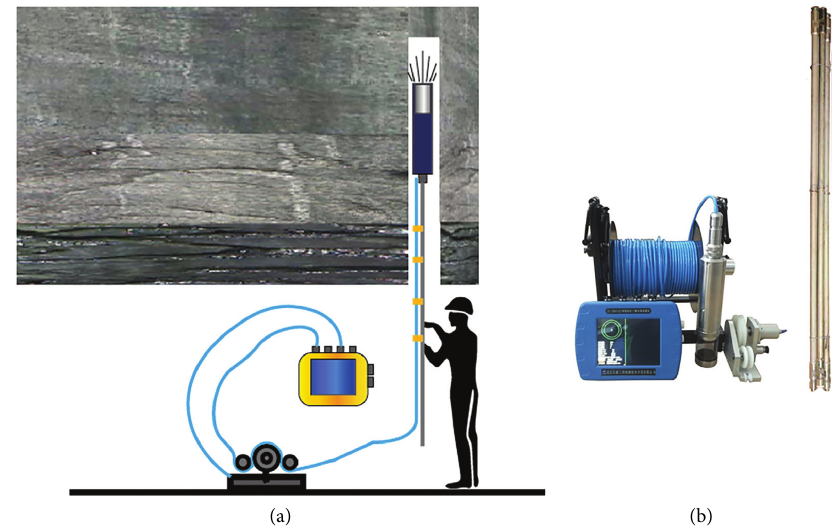
Figure 12: In-hole photography operation and equipment for roof blasting effect inspection.